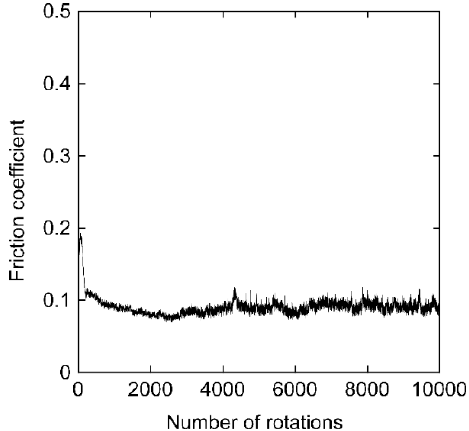
Figure 8. Friction coefficient of the bilayer sample vs. the number of rotations in the tribology experiment.